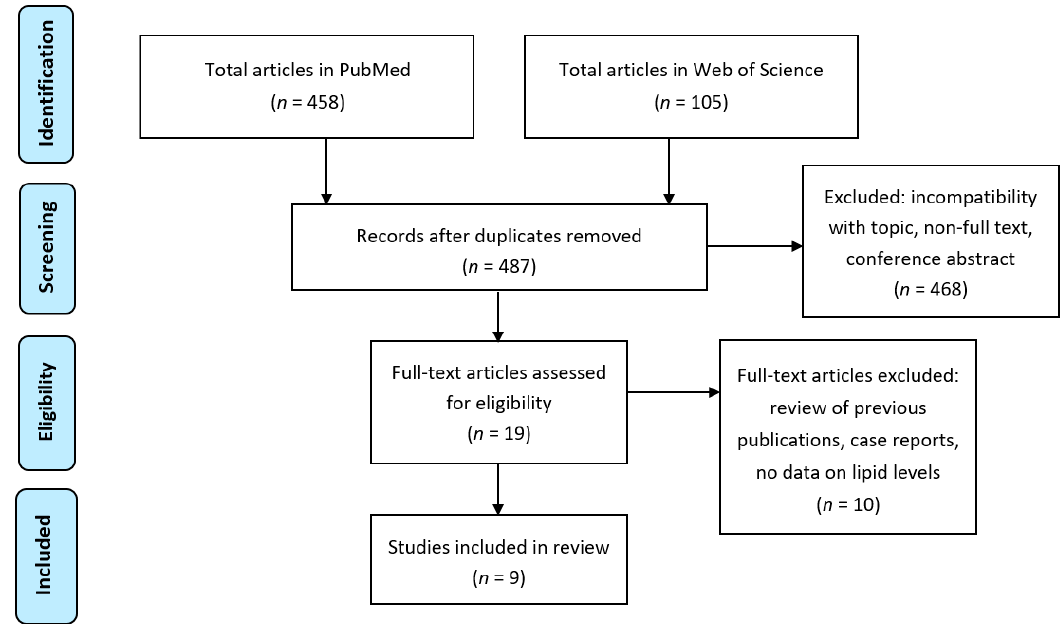
Figure 3. Flowchart of the retrieval of studies included in the review. The search terms were: “hyperemesis gravidarum”, “nausea and vomiting of pregnancy”, “fatty acid”, “PUFA”, “docosahexaenoic acid”, “eicosapentaenoic acid”, “arachidonic acid”, “eicosanoid”, “oxylipin”, “OXLAM”, “prostaglandin”, “bioactive lipid”, “lipid mediator”, “resolvin”, “endocannabinoid”, “lipid”, “phospholipid” and “sphingolipid”. Exclusion due to incompatibility with topic concerned studies related to medical treatments for incomplete miscarriage, termination of pregnancy, labor induction, acute fatty liver of pregnancy, liver disease in pregnancy, fertility control, marijuana use in pregnancy, contraceptive efficacy, dental practice, lipid peroxidation, antioxidant activity, thyroid function, total parenteral nutrition, mitochondrial beta-oxidation, oxidative stress and ginger. Full-text articles that were excluded concerned one review of previous publications (no new data), two case reports, one study on β -hydroxybutyrate, and the remaining six did not contain any data on lipid levels in samples from study participants. (PRISMA template for the flowchart was used [63].)